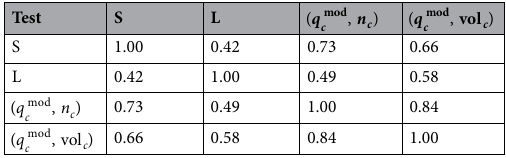
Table 3. Agreement between pairs of statistical tests.